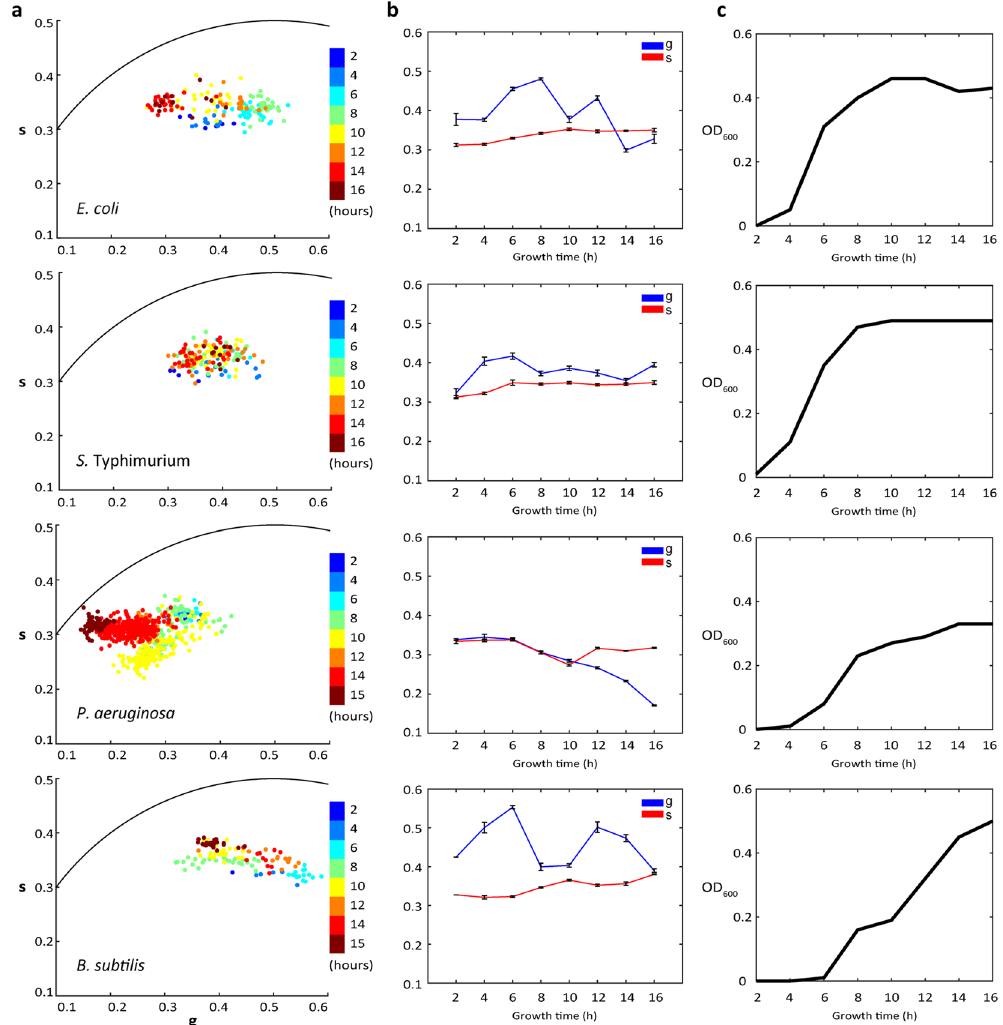
Figure 4. The effect of growth time on the bacterial phasor. ( a ) Bacterial phasor fingerprint of individual E. coli, S . Typhimurium , P. aeruginosa , and B. subtilis cells from aliquots taken at different shaking culture growth time points. ( b ) Mean g and s values along the growth curve, and ( c ) the corresponding optical densities of the shaking